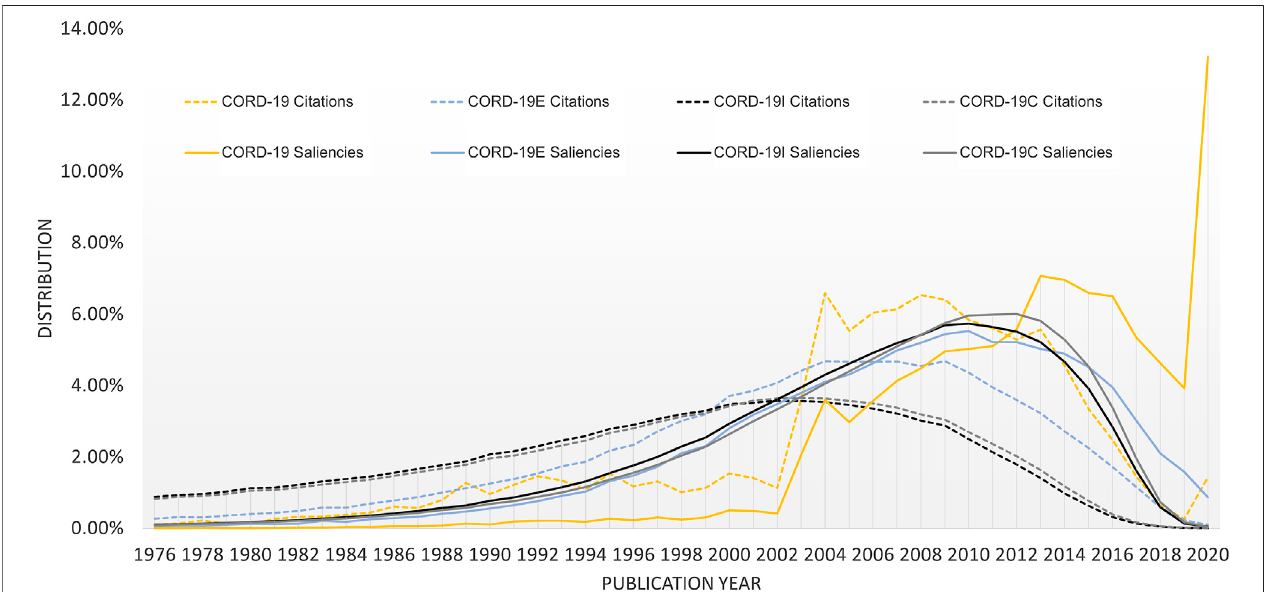
FIGURE 6 | Distribution of article importance as measured by citation counts (dotted lines) and saliencies (solid lines) for COVID-19 Research Dataset (CORD-19) and the three expanded datasets.